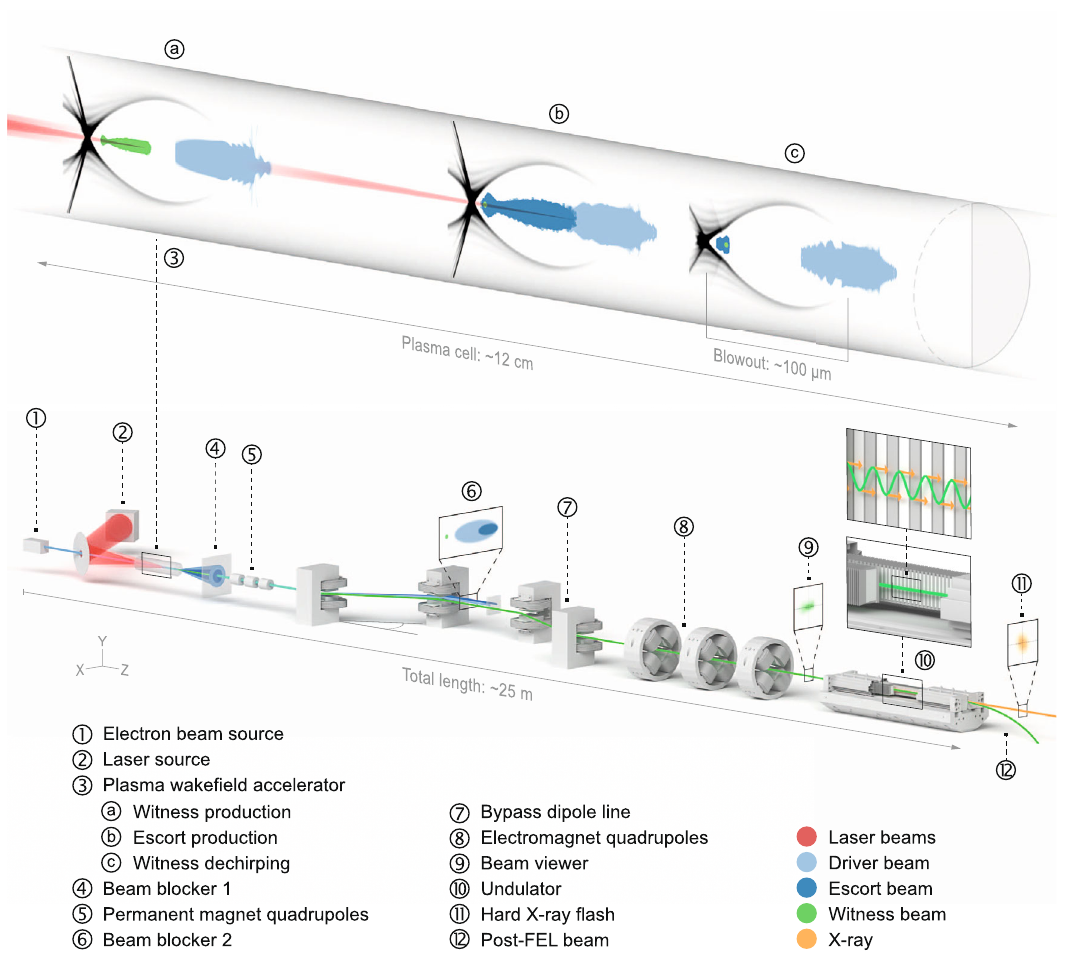
Fig. 1 | Setup. The electron beam driver ( 1 ) excites the PWFA ( 3 ), where fi rst a collinear plasma photocathode laser ( 2 ) produces the ultrabright witness electron beam ( a ), and then a second plasma photocathode ( b ) produces a high-charge escort beam that dechirps the witness beam via beamloading ( c ). These three electron populations leave the plasma, and high divergence escort and driver beams are partially dumped into a beam blocker ( 4 ). The witness beam passes the